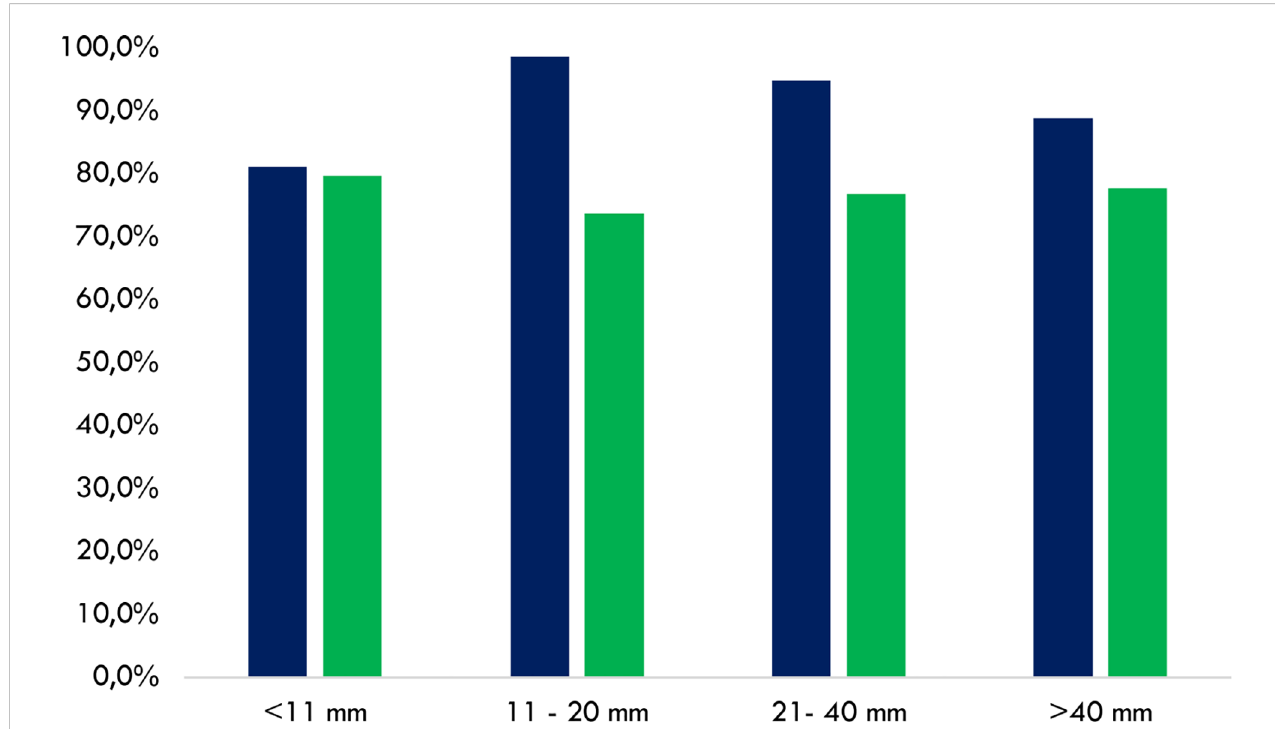
FIGURE 3 Cumulative concordance rates to perform or avoid FNA between the AACE/ACE/AME and TNAPP (blue) and the ACR TI-RADS and TNAPP (green). Data are illustrated by comparing rates among thyroid nodule diameters with different diameters (n = 188). AACE/ACE/AME, American Association of Clinical